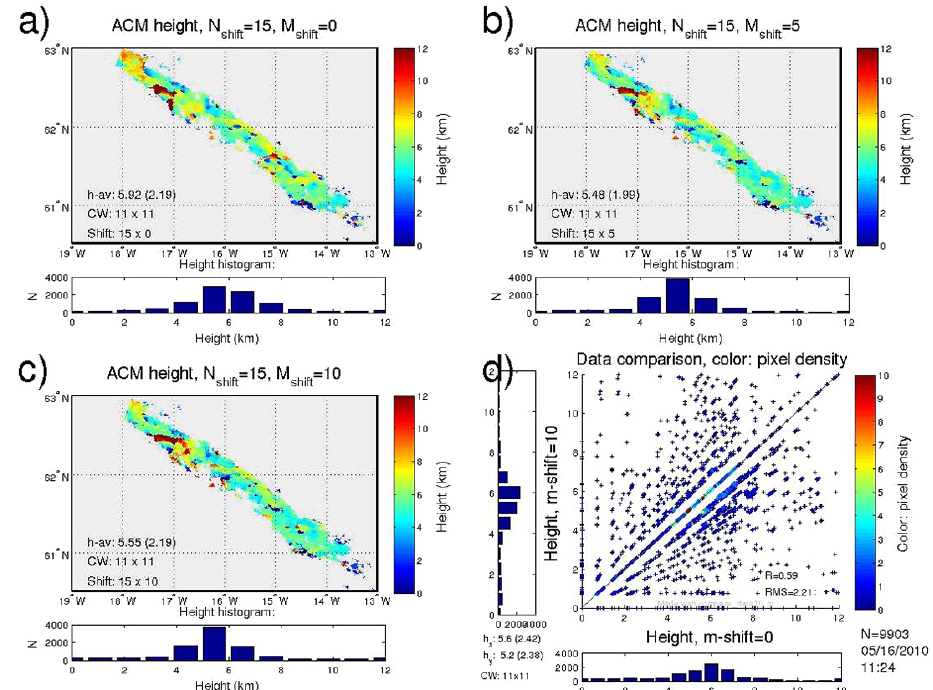
Figure 6. Effect of the maximum allowed across-track shift, M shift (or M ), is much larger than that of N shift . However, the difference between M = 5 and M = 10, for example, is already much smaller ( R = 0 . 89, not shown) than between M = 0 and M = 10, shown here ( R = 0 .